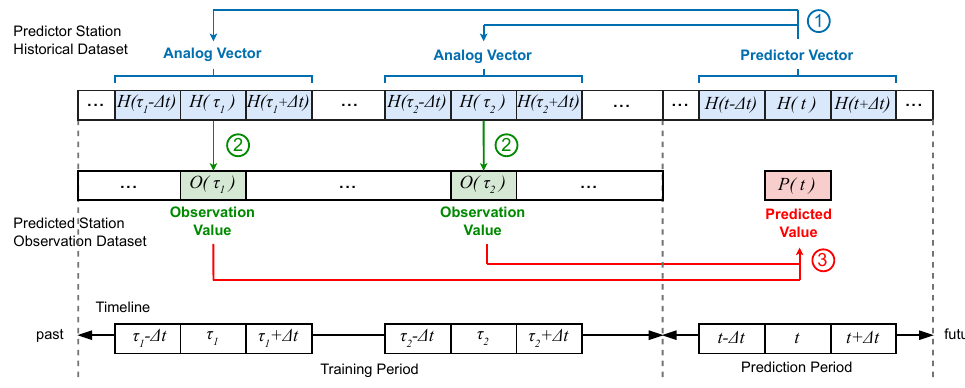
Figure 1. Reconstruction of meteorological data with the analogues ensemble method ( k =